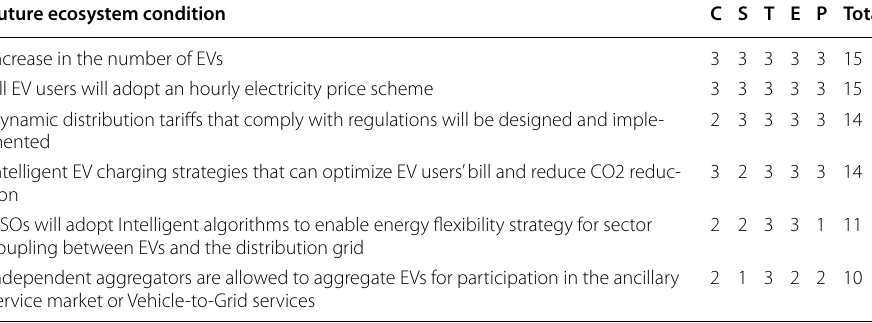
Table 24 The identified transition stages of the EV home charging energy ecosystem with future ecosystem conditions Future ecosystem condition Transition